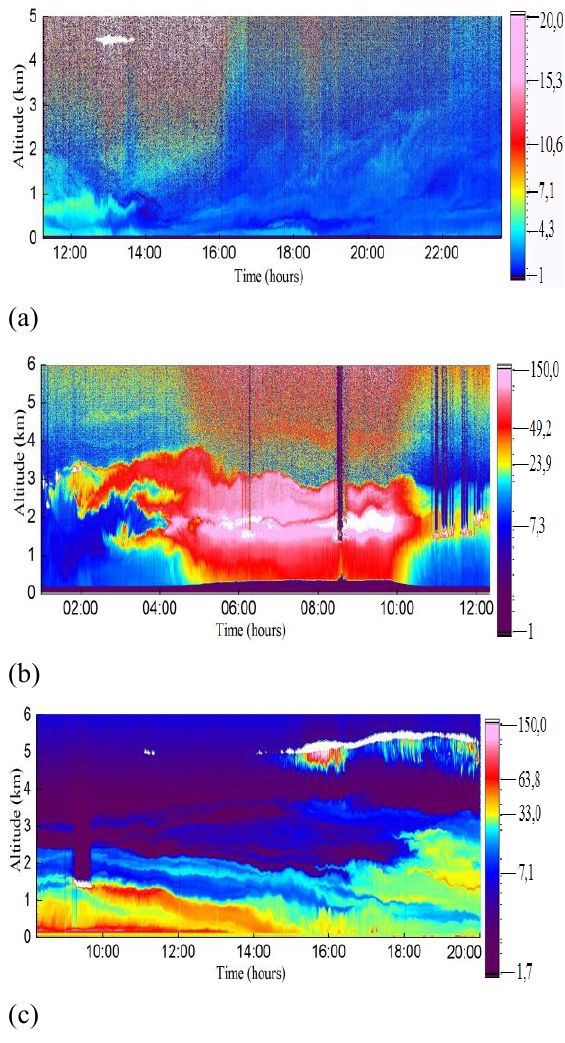
Fig.2 Spatiotemporal structure of aerosol field, obtained: (a) – by the lidar at the research vessel «Academician V.A. Koptyug» on July 19, 2018; (b) – by the lidar at the research vessel «Academician V.A. Koptyug» on July 22, 2018; (c) – by the lidar at the Boyarsky stationary site on July 22, 2018. Color scale is given in scattering ratio